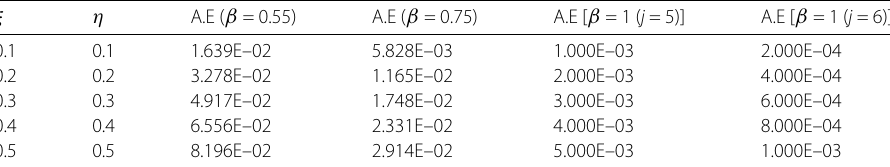
Table 1 LADM solutions of Example 1 at different fractional order β and its corresponding absolute error (A.E) of u at τ =